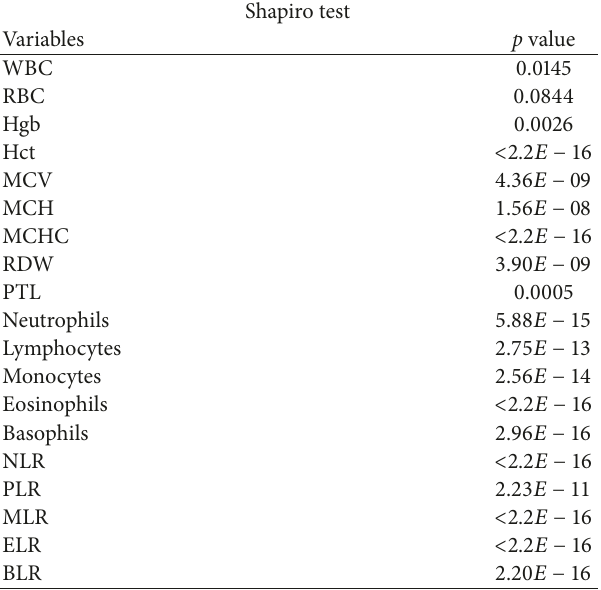
Table 3: Results of the Shapiro-Wilk normality on the variables related to the blood